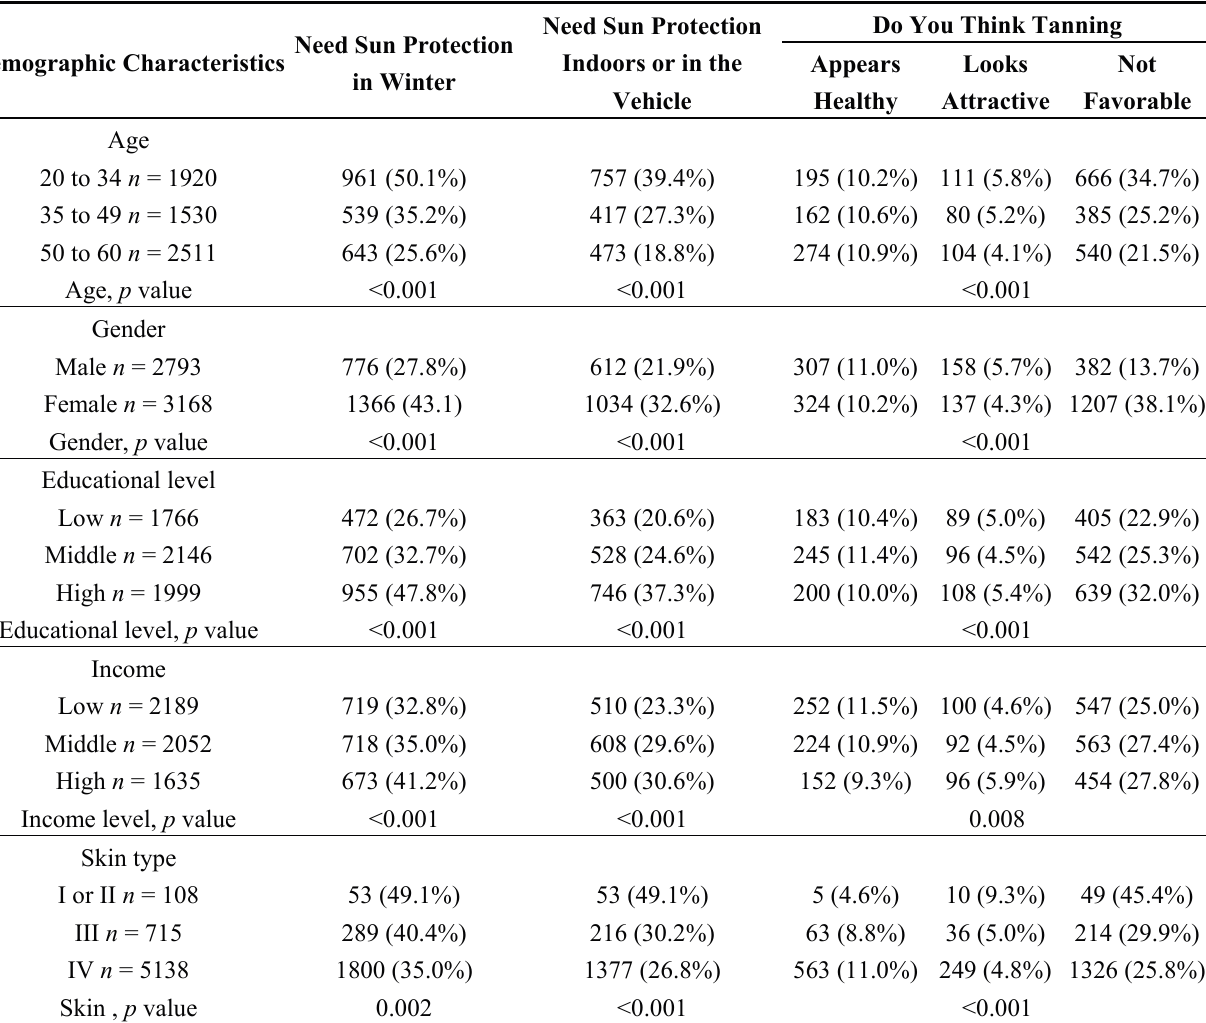
Table 4. Sun protection attitudes of the 5961 responders, stratified by age, sex, education level and